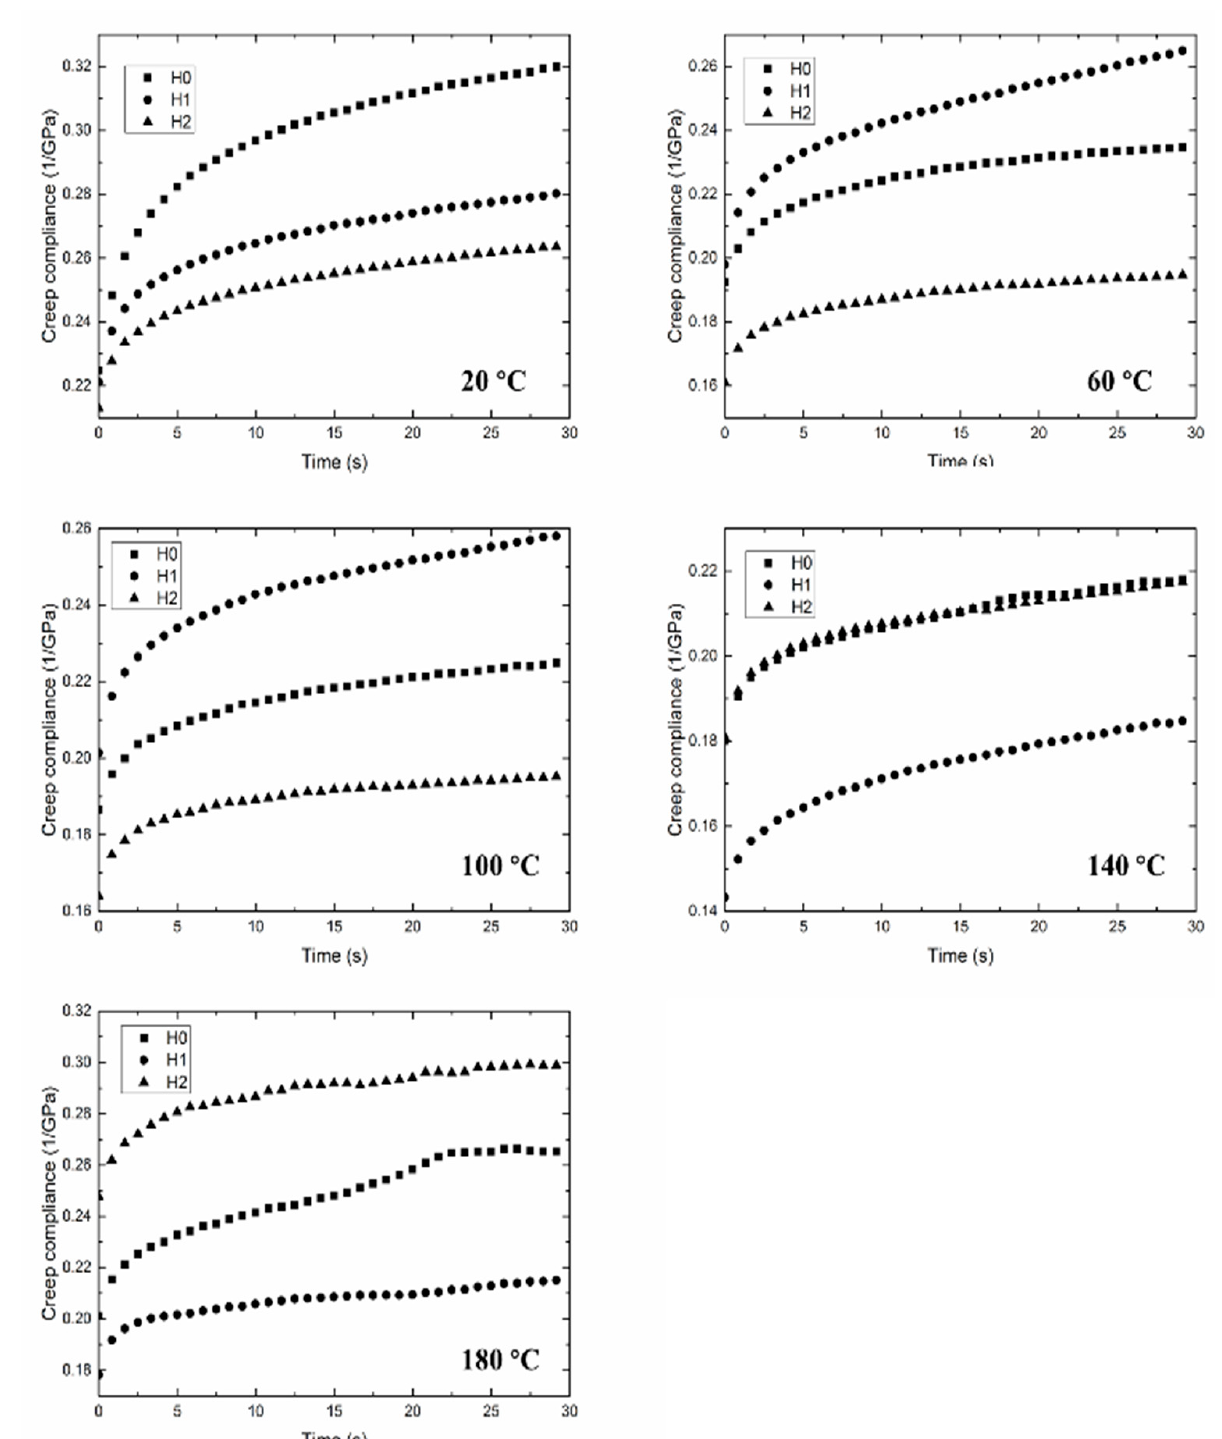
Figure 7. The effect of heat treatment on the creep compliance of the wood cell wall.